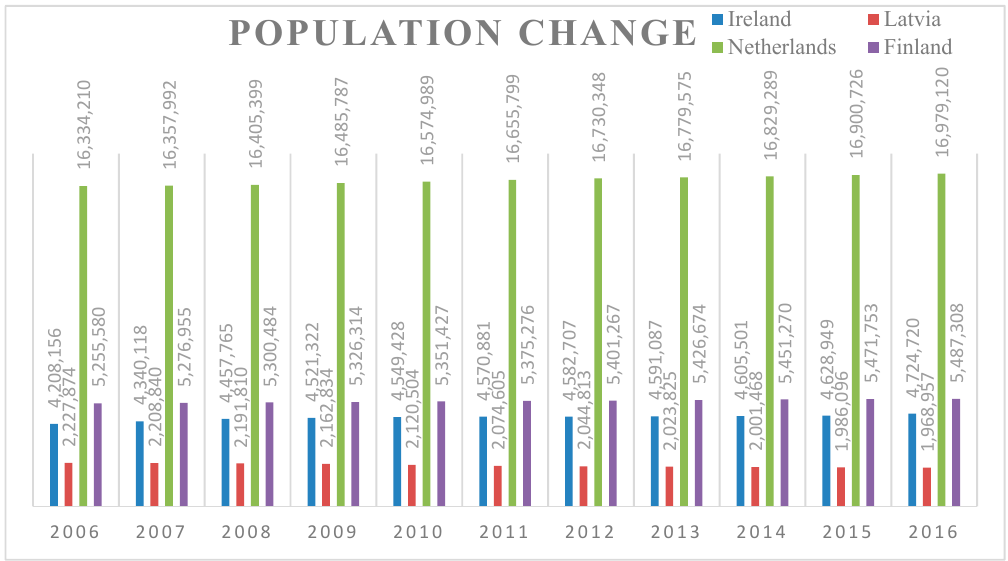
Figure 1. Population change data 2006–2016 (based on Eurostat, 2017 [9]).